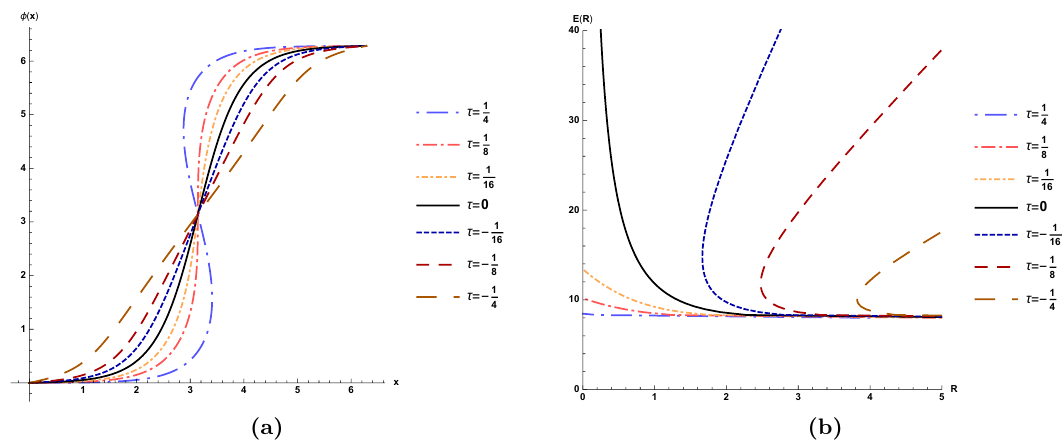
Figure 5. The kink solution to the T(cid:22)T-deformed sG model on a cylinder of radius R (a) and the corresponding energies as functions of R